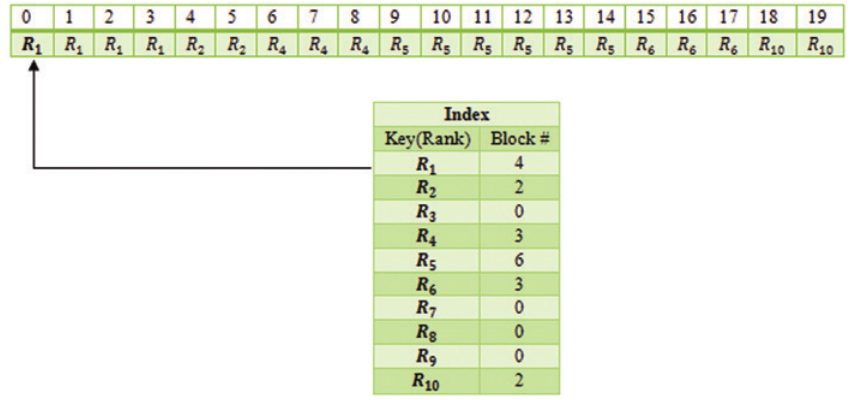
Figure 3: Resource Searching With